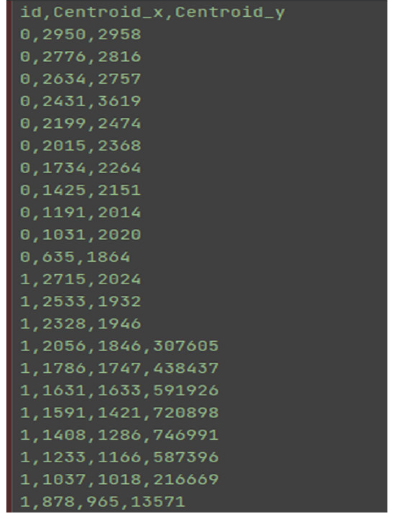
Figure 12. Cloud position